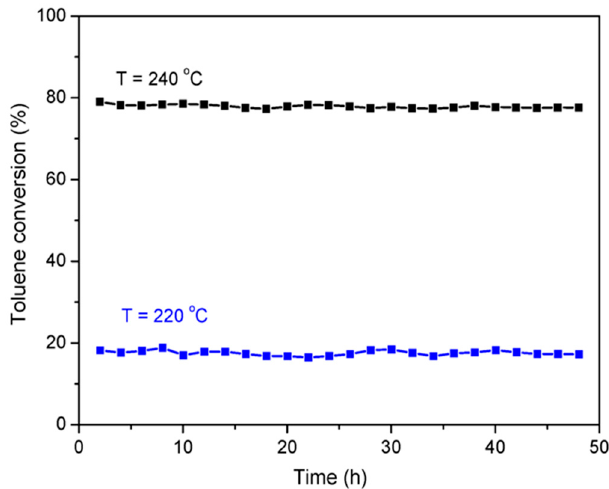
Figure 8. Long–time stability test for the CoCe–MA catalyst in the combustion of toluene at 220 and 240 °C. Reaction conditions: 500 ppm toluene, balanced dry air, total flow rate: 100 mL/min, 300 mg catalyst, GHSV = 20,000 mL/(g·h).